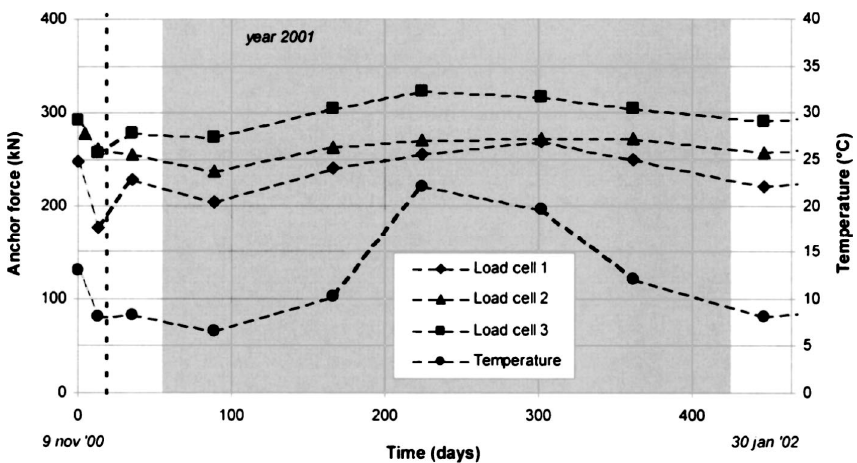
Figure 12. Overview of the monitoring results during a period of more than 1 year after installation of the ground anchors [45].